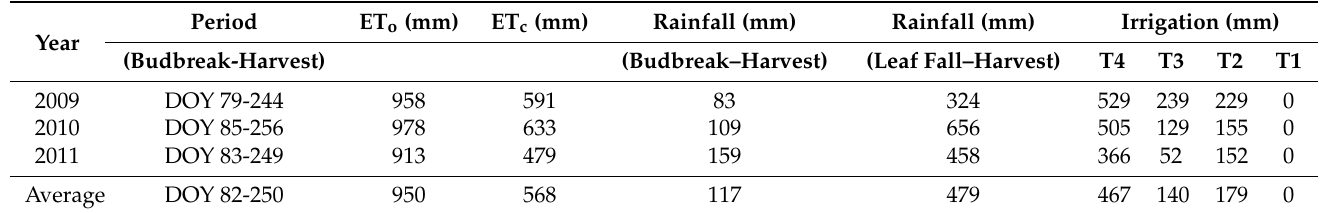
Table 1. Reference evapotranspiration (ET o ) and crop evapotranspiration (ET c ), rainfall, and volumes of irrigation water in each of the treatments between budbreak and harvest in 2009, 2010, and 2011.